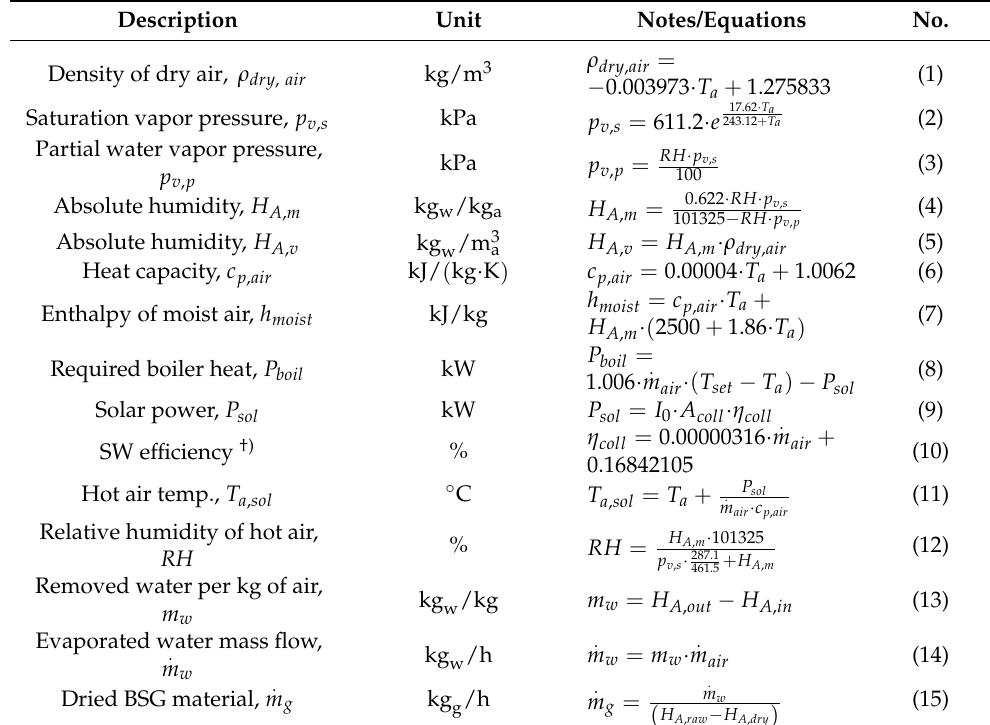
Table 4. Summary of the input parameters and the equations used in time-resolved thermodynamic calculations (“calc.” refers to the calculated values).